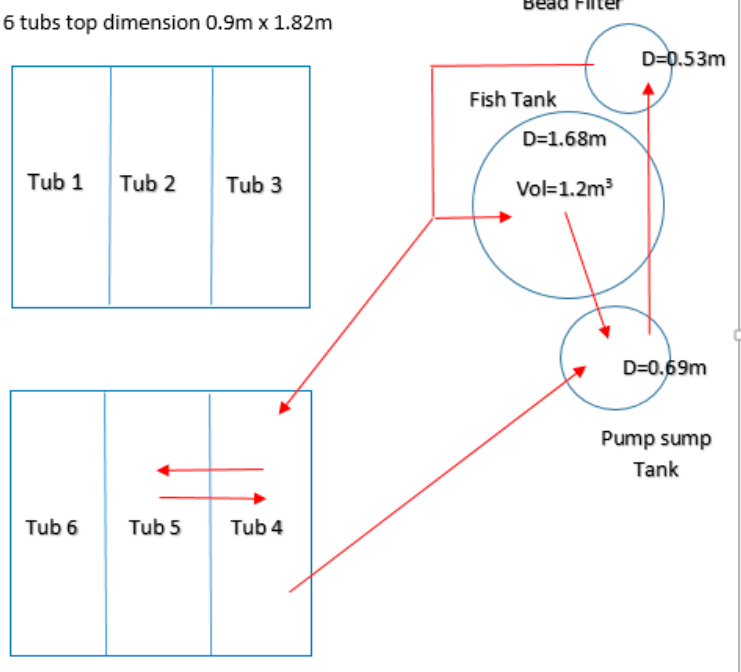
Figure 1. Greenhouse experiment floor plan (to scale); ebb and flow table not shown (was immediately north of Tub 4). Red arrows between the fish tank, Tub 4, and the pump tank illustrate the water recirculation path and continuous gravity equilibration of water between tub 4 and 5. Flow from the bead filter is partially diverted to tubs 4 and 5, and the balance directly returned to the fish tank. Top of the figure is the due west wall. D, diameter.